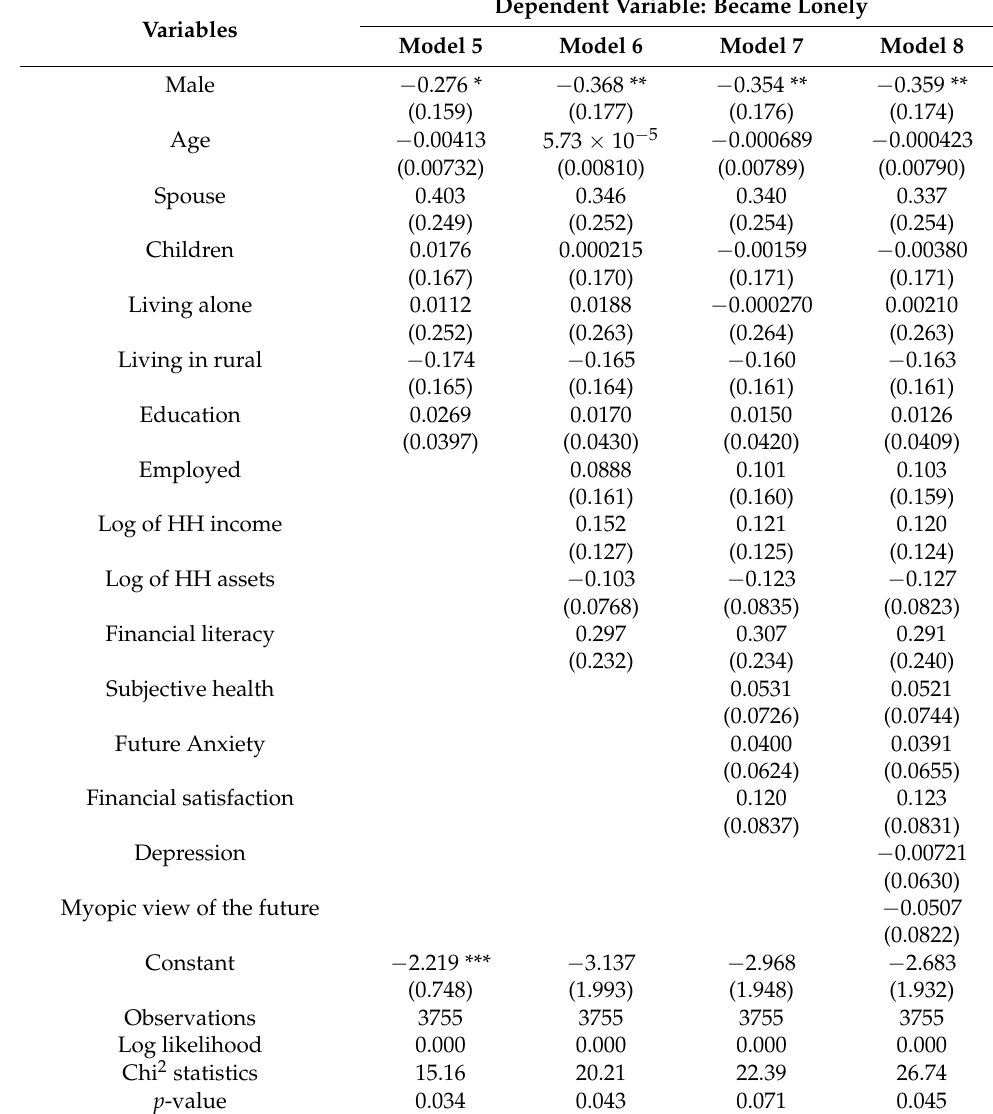
Table 7. Logit regression results of becoming lonely in 2021 (full sample